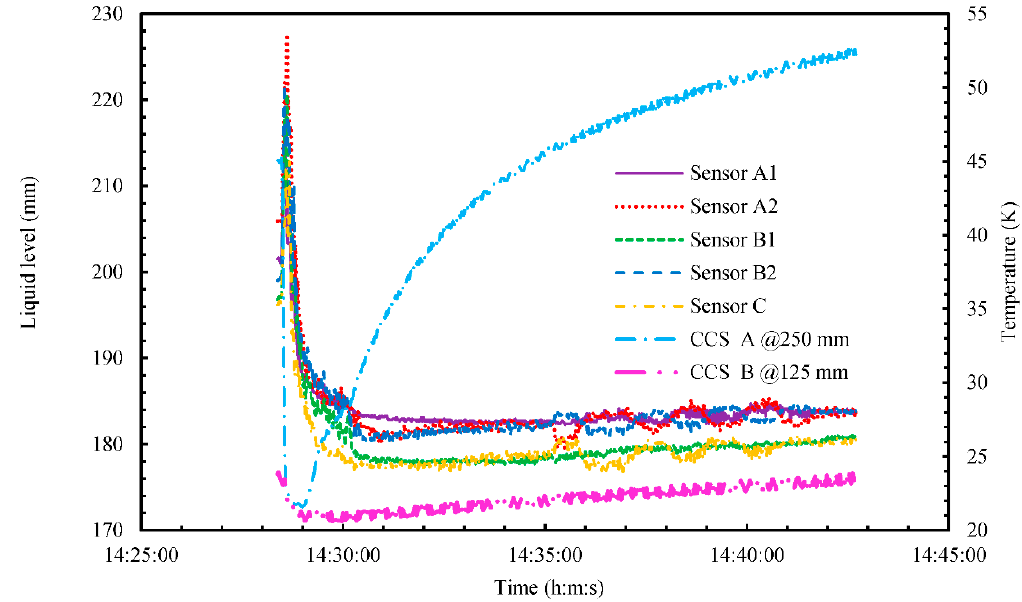
Figure 9. Time series of liquid level and temperature inside the cryostat during marine-transportation test ⑤ from 14:28 to 14:42.